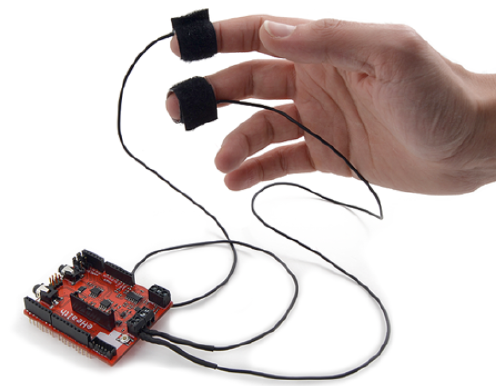
Figure 3. GSR electrode connected to e-Health sensor